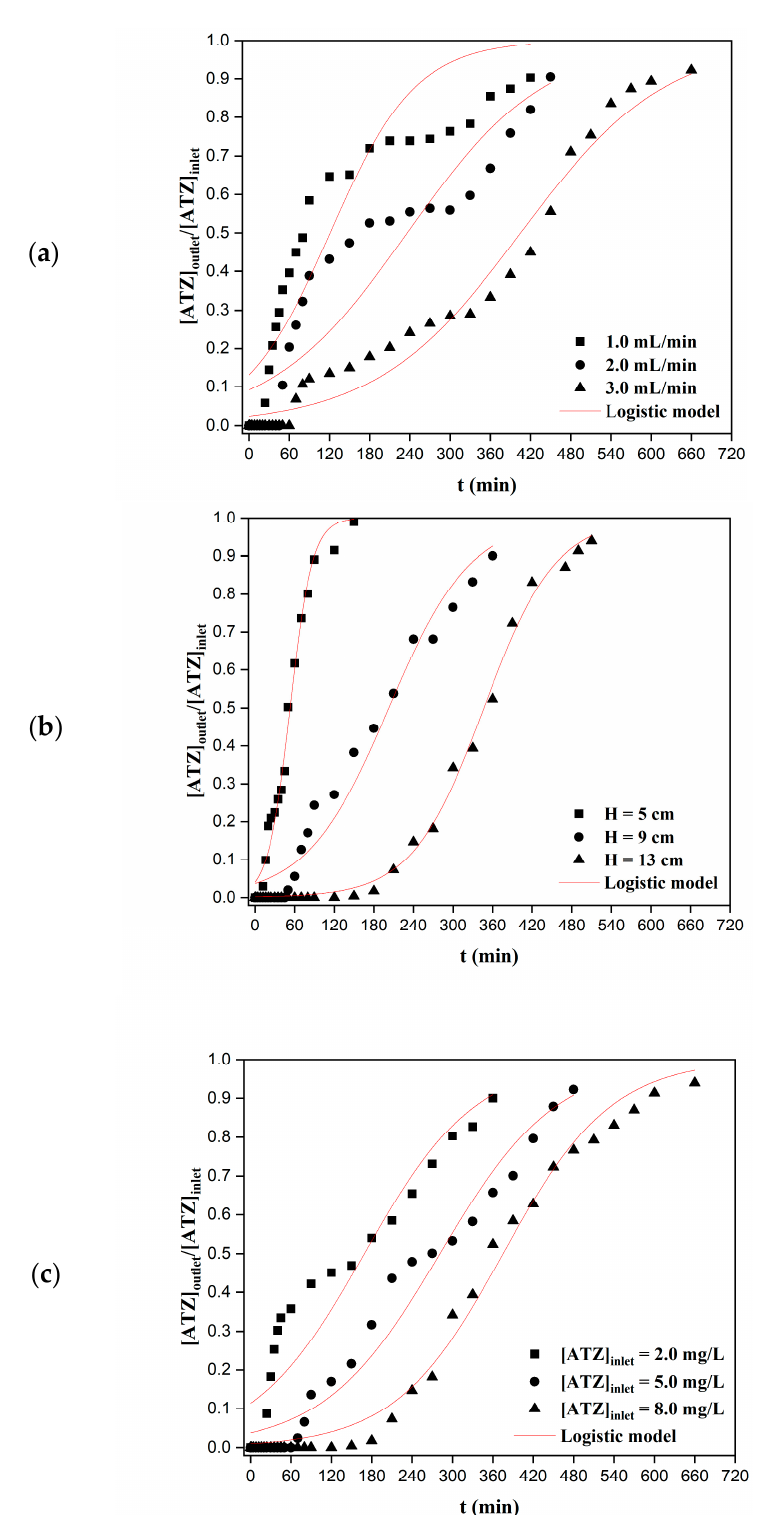
Figure 7. Logistic model fitting for the packed-bed column adsorption of ATZ using Moringa oleifera Lam. seeds as adsorbent for: ( a ) different peristaltic pump flow rate with solution pH 5.0, fixed bed height (13 cm), and [ATZ] inlet = 2 mg L − 1 at T = 25 ◦ C; ( b ) different bed heights with [ATZ] inlet = 2 mg L − 1 , flow rate of 1 mL min − 1 , and pH 5.0; ( c ) effect of the inlet ATZ concentration with flow rate fixed at 1 mL min − 1 , pH 5.0, and bed height of 13 cm.